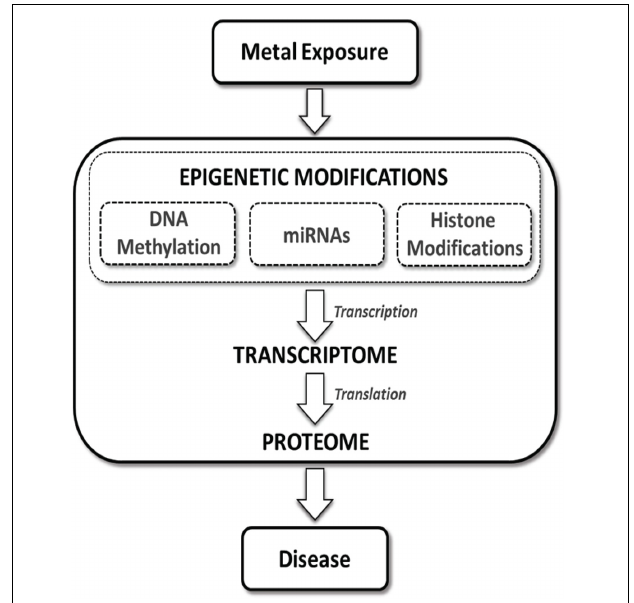
FIGURE 1 | The role of the epigenome in toxic metal-induced disease pathways. Epigenetic alterations classified broadly as effects to the “epigenome” have the potential to regulate mRNAs/transcripts (i.e., the transcriptome) and ultimately impact protein expression (i.e., the proteome) within cells. Exposure to toxic metals can impact various components of the epigenetic machinery. These toxic metal-mediated epigenetic alterations may directly impact gene transcription and subsequently regulate protein translation, leading to aberrant expression of key mediators of disease